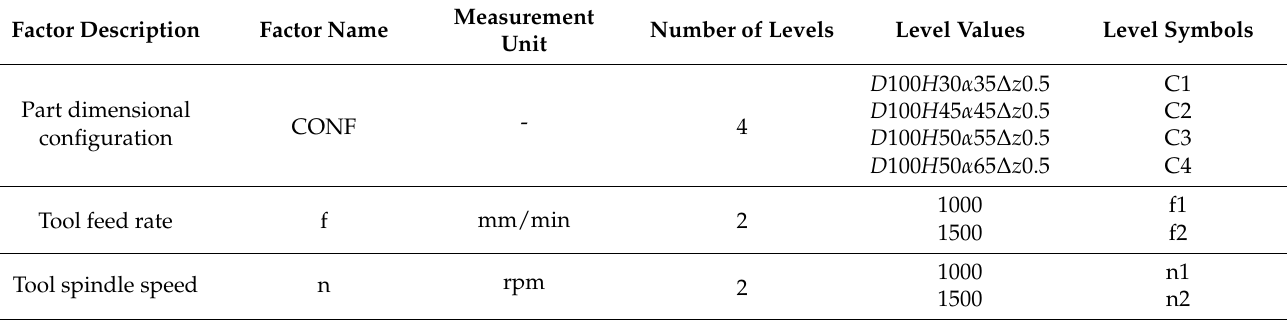
Table 2. Design of experiment (DOE) factors and levels [5].